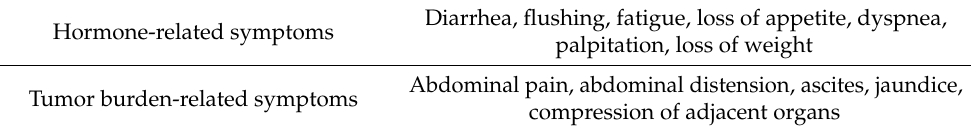
Table 3. Common symptoms affecting HRQoL of NET